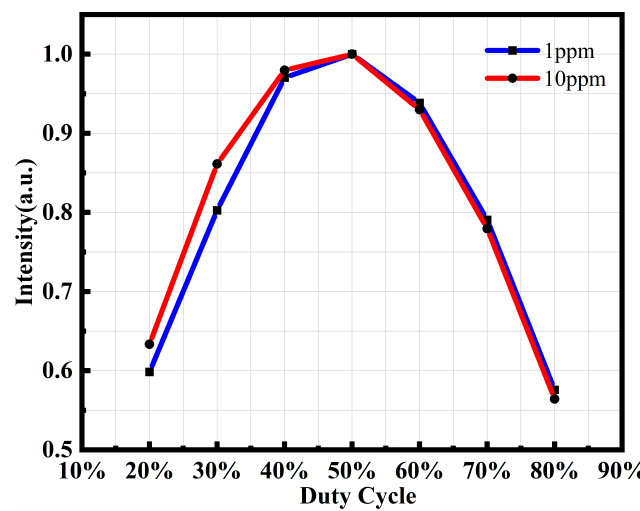
Figure 6. The relationship between duty cycle and photoacoustic signal.